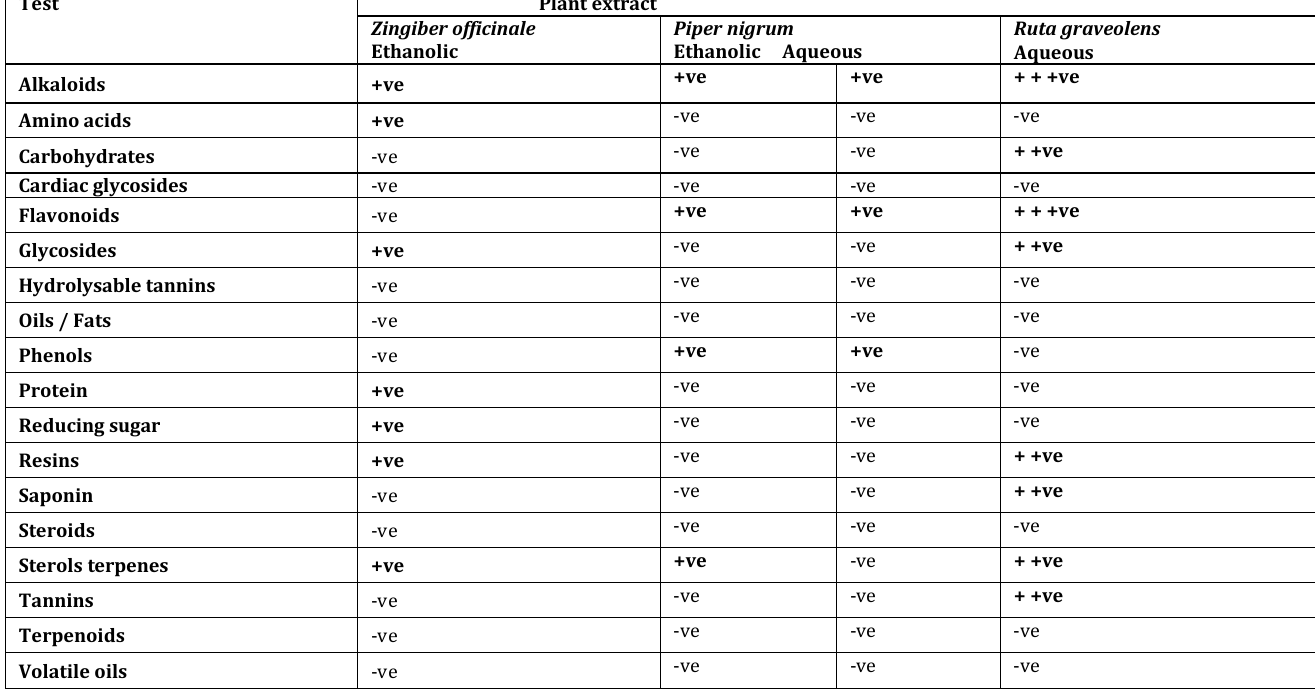
Table 1: Qualitative analysis of plant extract.